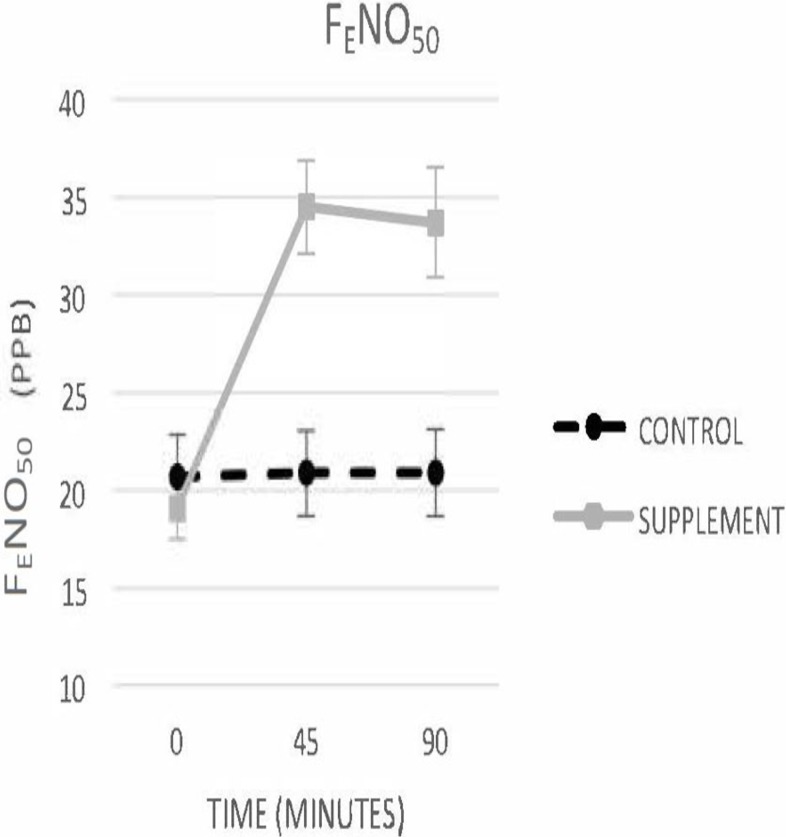
Average values of FENO50 on both control and experimental days.Error bars indicate standard error.